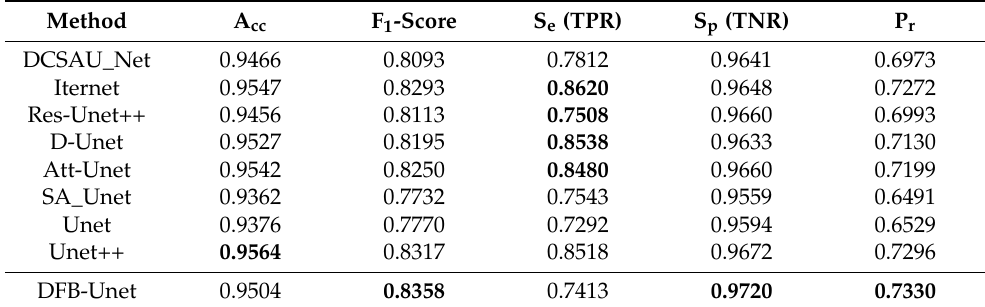
Table 6. Performance metrics on the CHASE_DB1 dataset versus contrast with other models.